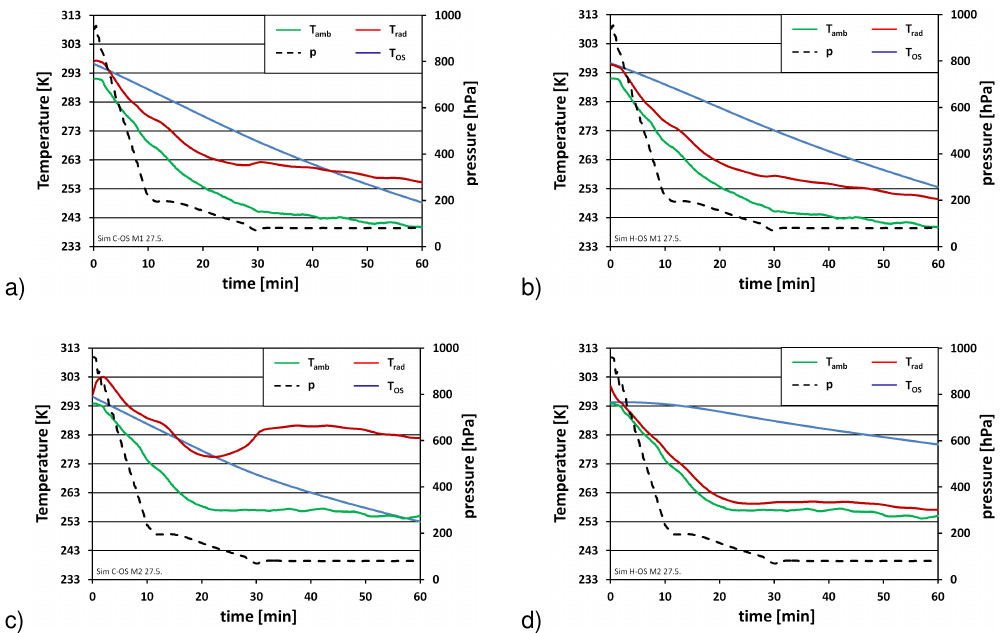
Fig. 11. Simulated thermal behaviour of GBB optical surfaces in two different scenarios. Upper panel: Scenario No. 1 (cold instrument compartment) for (a) GBB-C and (b) for GBB-H. Lower panel: Scenario No. 2 (warm instrument compartment) for (c) GBB-C for (d) GBB-H. Table 3. Estimated heat loads for the 44